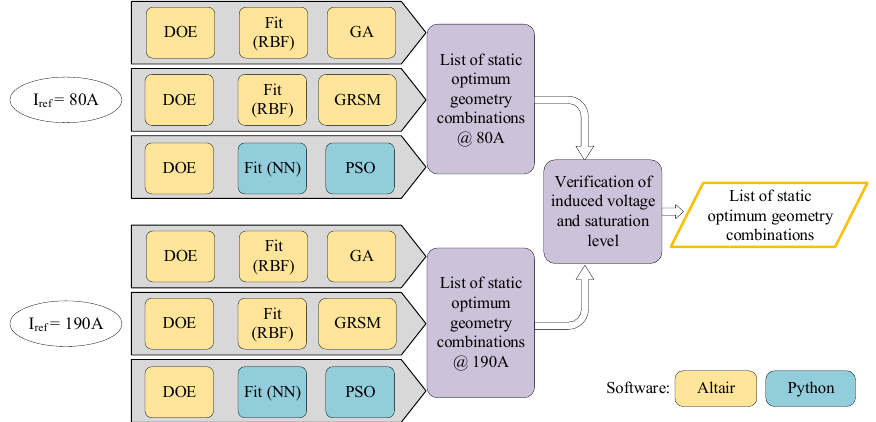
Figure 4. Block diagram of the static design: fit models and global optimizations used for two different current ratings [23].